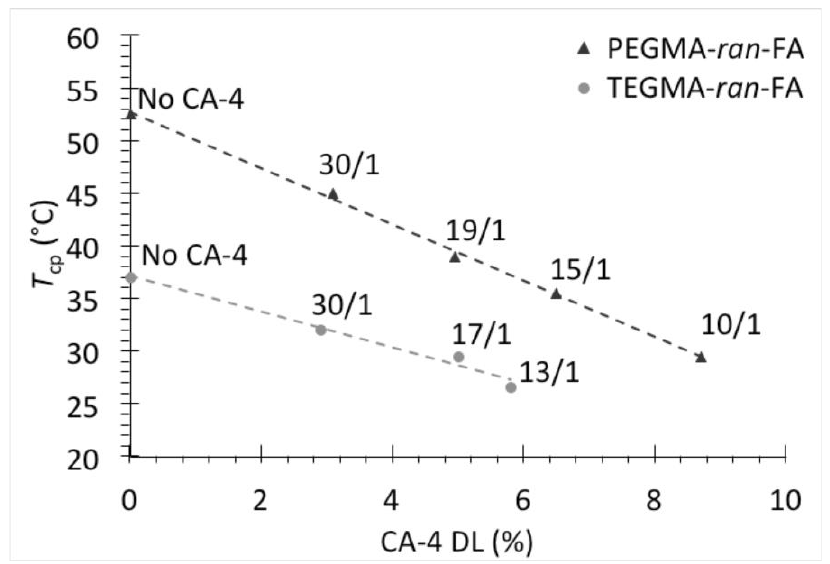
Figure 7. Cloud point temperature ( T cp ) of the systems PEGMA- ran -FA/CA-4 (triangles) and TEGMA- ran -FA/CA-4 (circles) as a function of drug loading (DL).